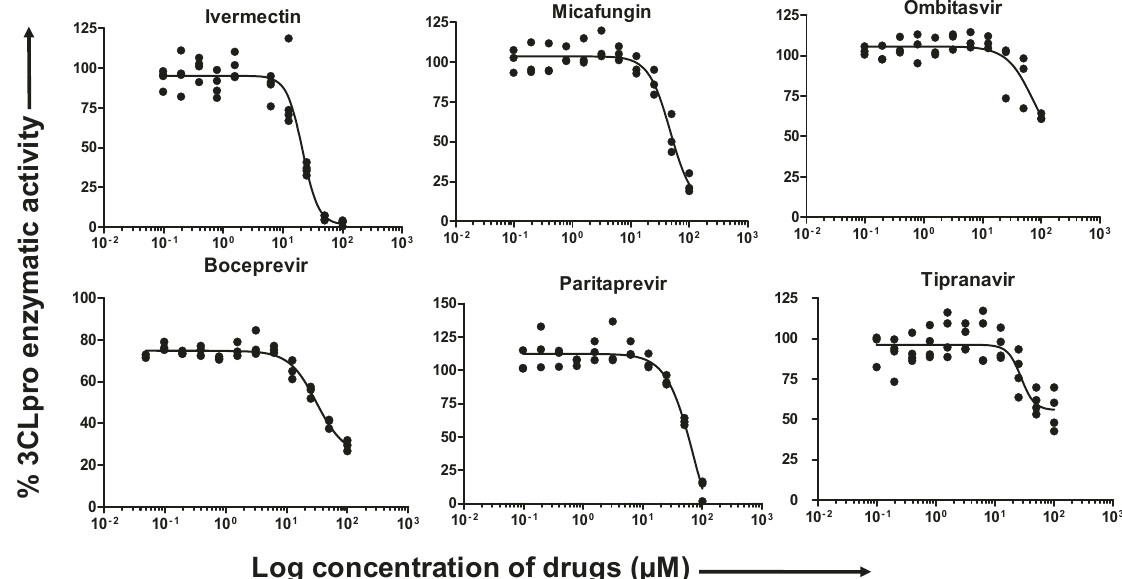
Fig. 5 Dose-dependent inhibition of SARS-CoV-2 3CLpro activity by selected PIs, VNIs, and OTDs. The drug candidates that exhibited more than 50% of inhibitory activity at 50 µ M concentration were selected for dose-dependent and IC 50 calculation studies. A serial dilution of drugs ranging from 0 to 100 µ M in assay buffer was used. The percent activity was calculated as described in Fig. 1 legend. Representative of three individual experiments with triplicate values were presented graphically ( n = 3). Non-linear regression (curve fi t) with four variable dose vs inhibition was used to calculate the IC 50 values using GraphPad Prism. Table 2 IC 50 values of non-viral protease inhibitor drugs for SARS-CoV-2 3CL protease. SL.